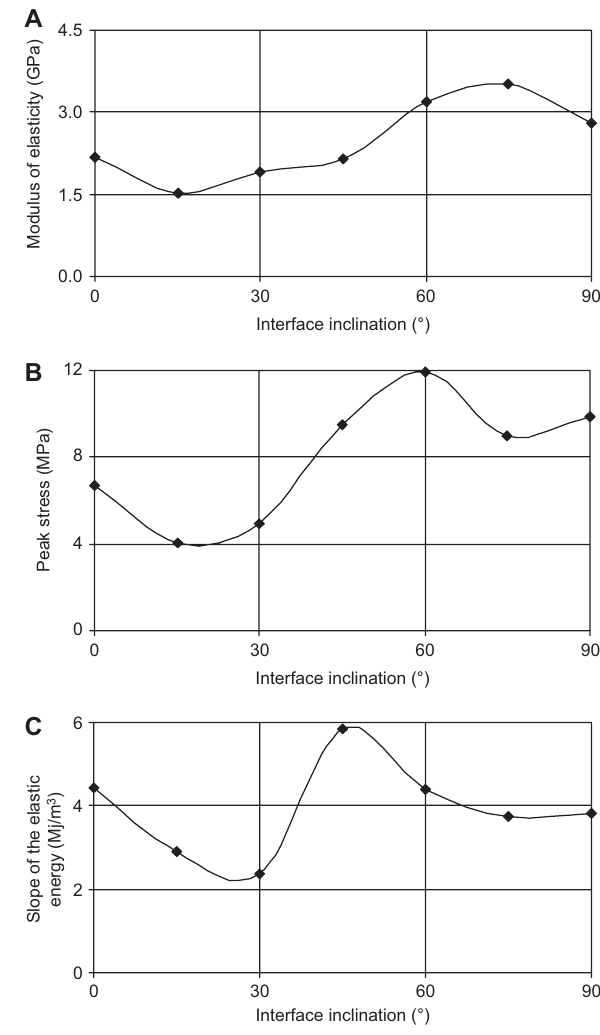
Figure 19 The variation of (A) the modulus of elasticity, (B) the peak stress and (C) the slope of the elastic strain energy density